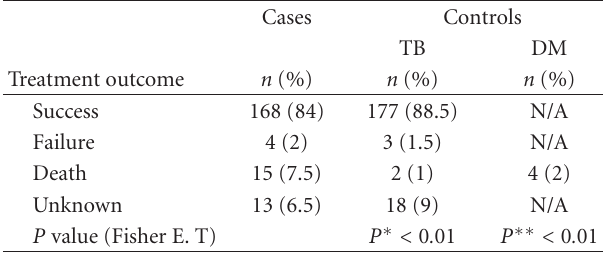
Table 5: TB treatment outcome. Table 6: Binary logistic regression analysis for